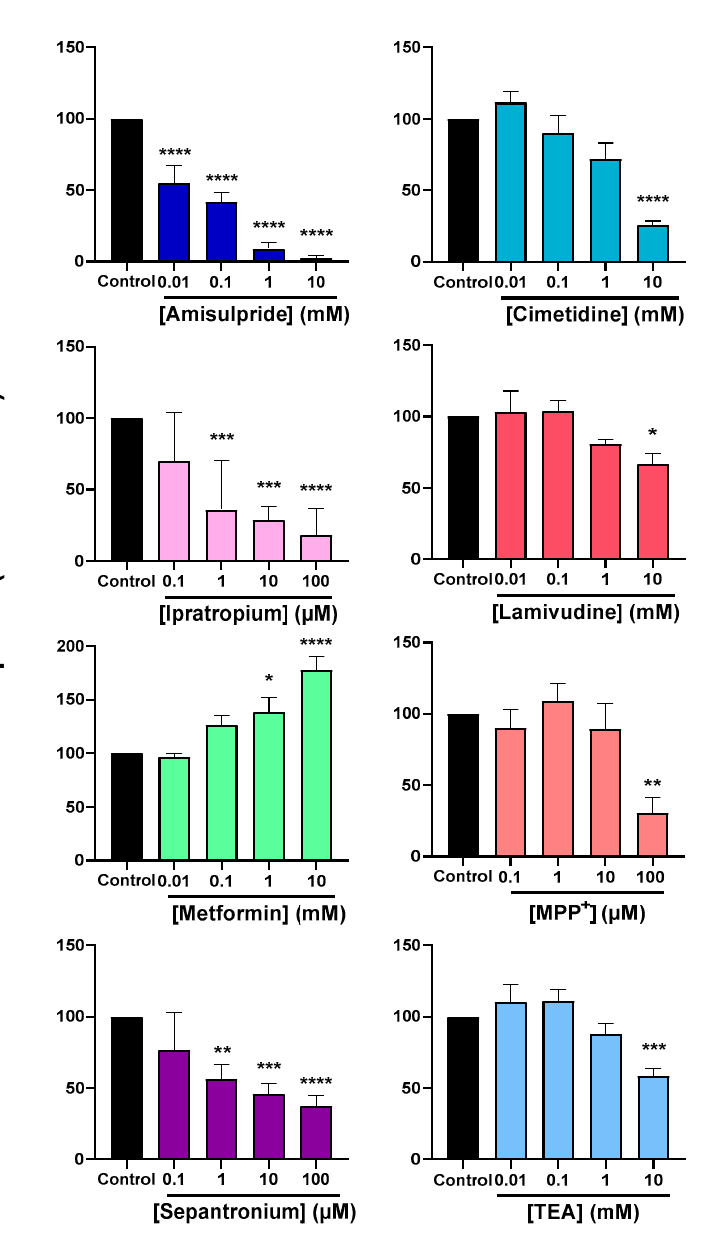
Figure 5. Trans -modulation of OCT2 activity by exogenous OCT2 substrates. HEK-OCT2 cells were first incubated in the absence (control) or presence of various concentrations of exogenous OCT2 substrates for 30 min at 37 °C. After washing, cells were next incubated with 10 µM DiASP, used here as a tracer substrate for OCT2, for 5 min at 37 °C. Accumulation of DiASP was finally determined by spectrofluorimetry and normalised to protein content. Data are expressed as % of DiASP accumulation found in untreated control cells, arbitrarily set at 100%; they are the means ± SEM of at least three independent experiments performed in quadruplicate. *, p < 0.05, **, p < 0.01, ***, p < 0.001 and ****, p < 0.0001, when compared to control.